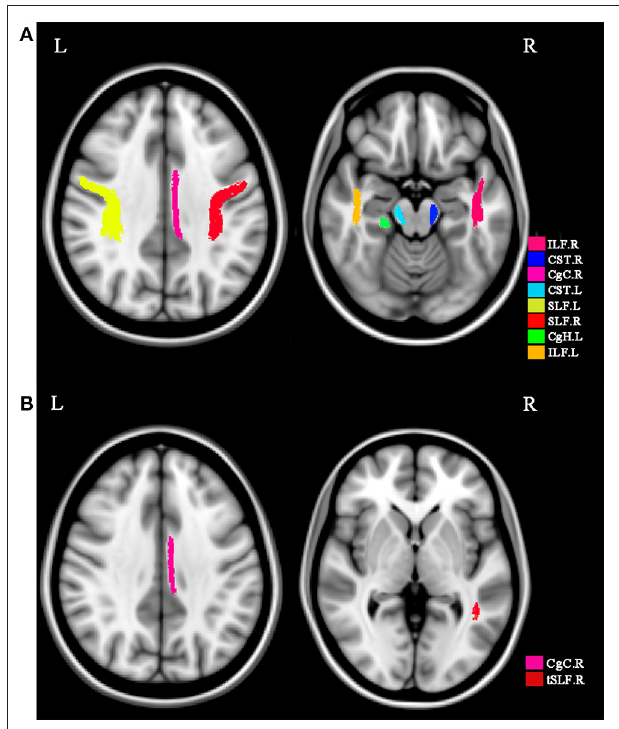
FIGURE 1 | WM regions with significant differences among dPD, ndPD, and HC. Significant WM regions are marked by various colors in the axial planes. (A) The FA values of white matter tracts with significant difference among groups. (B) The MD values of white matter tracts. These WM regions include CST.L, CST.R, CgC.R, CgH.L, ILF.L, ILF.R, SLF.L, SLF.R, CgC.R, tSLF.R. CST, corticospinal tract; CgC, cingulum (cingulate gyrus); CgH, cingulum hippocampus; ILF, inferior longitudinal fasciculus; SLF, superior longitudinal fasciculus; tSLF, superior longitudinal fasciculus-temporal part; FA, fractional anisotropy; MD, mean diffusivity; R, right; L,